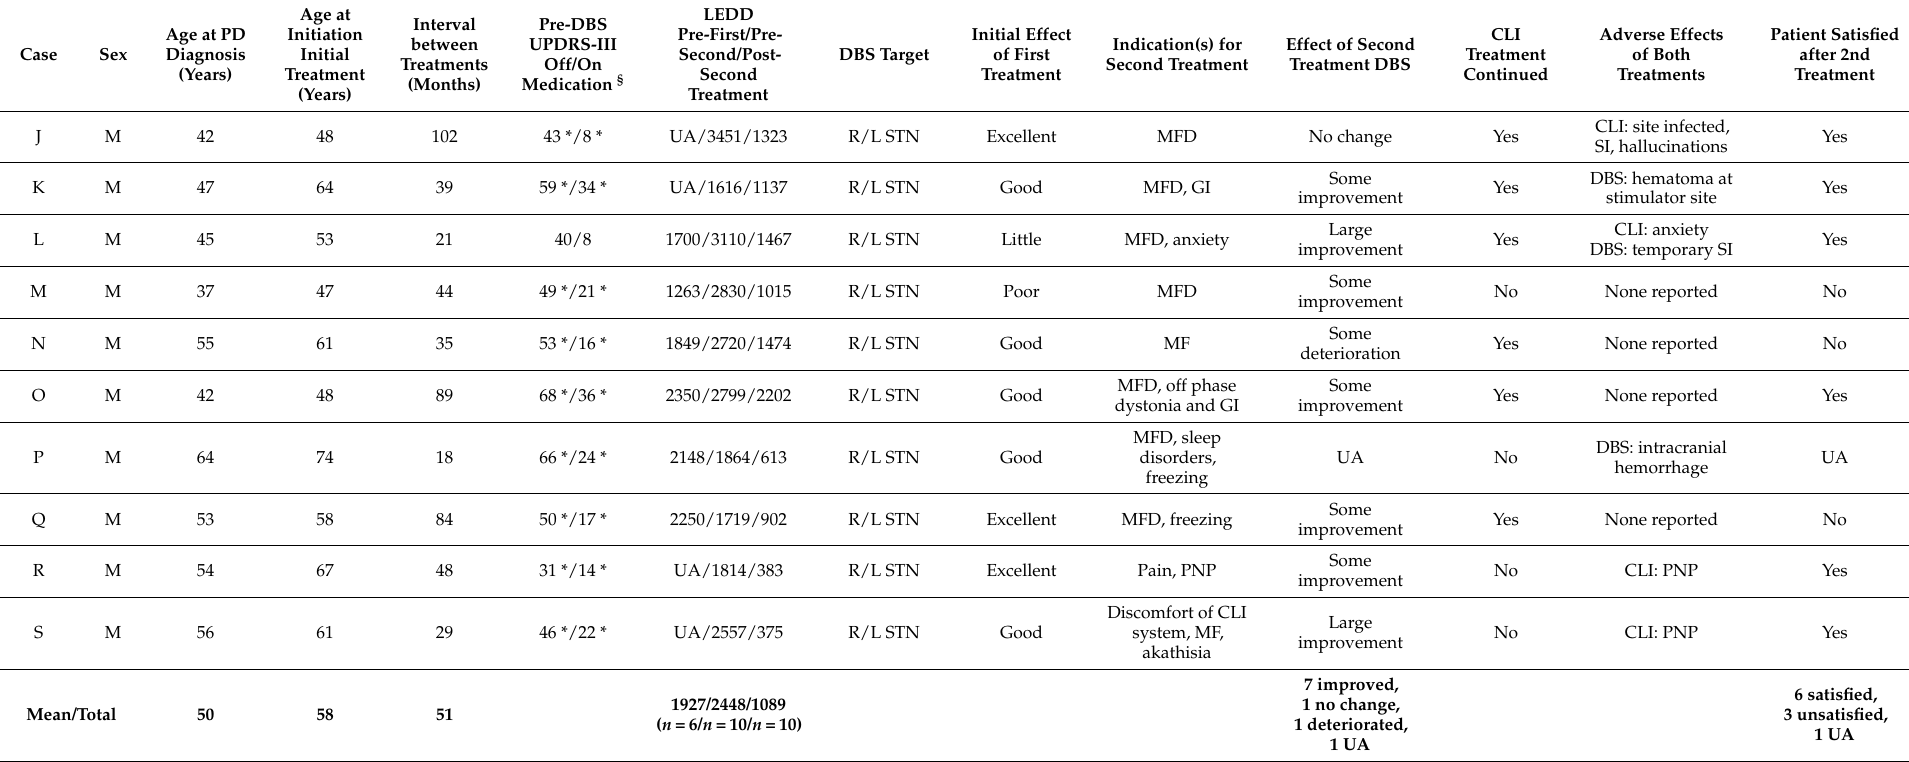
Table A2. Parkinson’s disease patients firstly treated with CLI, DBS as second treatment—single